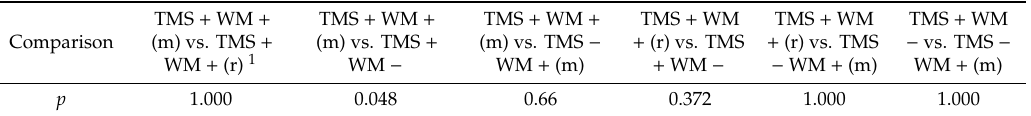
Table 3. Post-hoc analysis of di ff erences in high-load n-back task with spatial stimuli (Wilcoxon test with Bonferroni correction for multiple